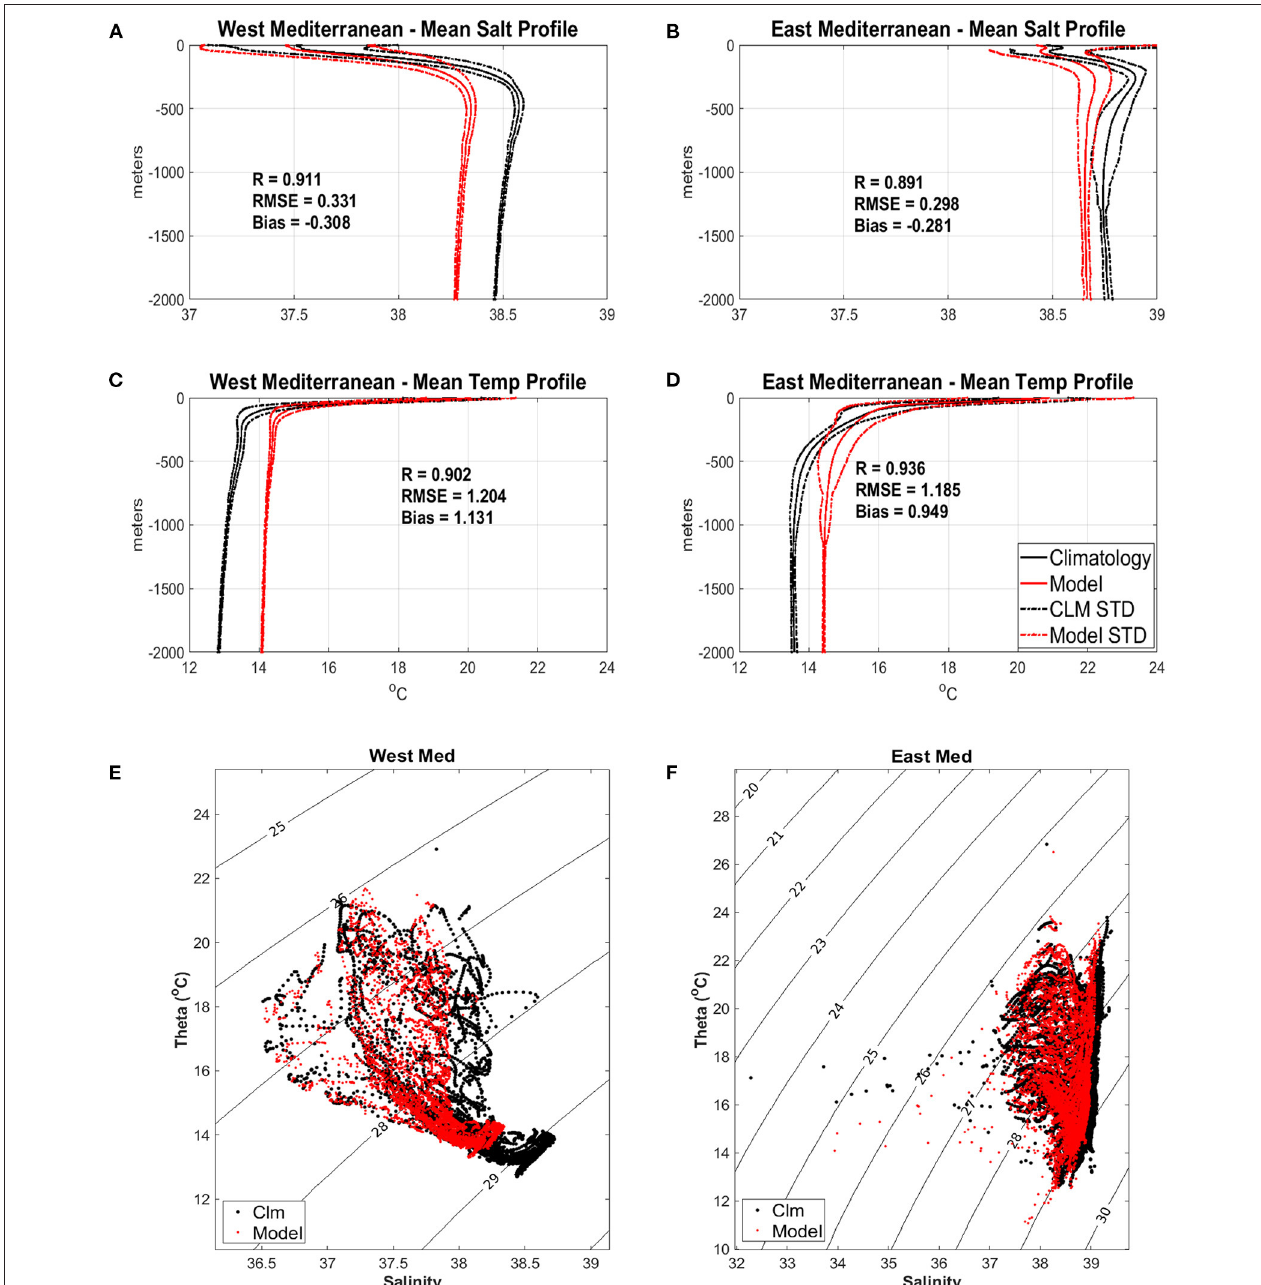
FIGURE 1 | Comparison of simulated (red) and observed (black) salinity (top) and temperature (middle) profiles for the Western (A,C) and Eastern (B,D) basins. Both mean profiles (solid lines) and mean ± one standard deviation (STD) (dashed lines) over the complete data sets are presented. The comparison of the mean values is extended to the corresponding θ / S diagrams in the bottom panels (E,F)